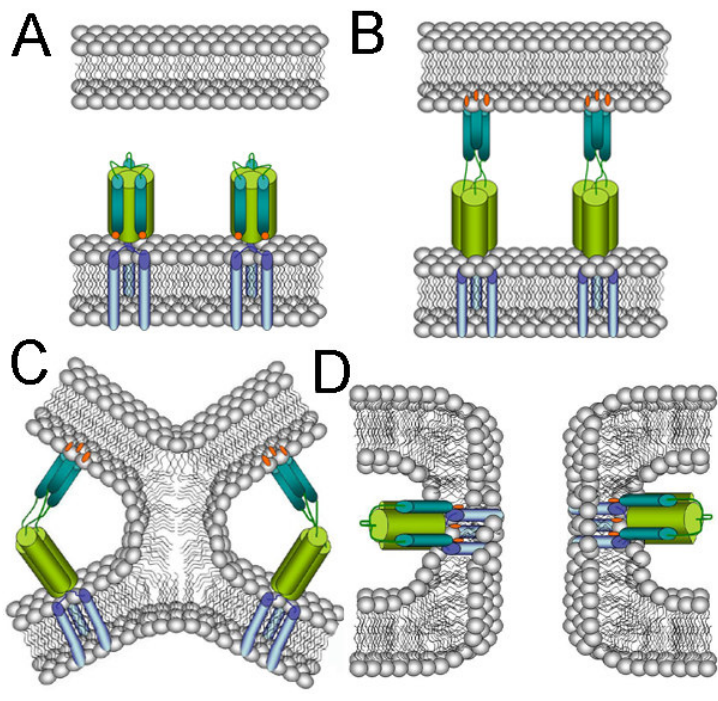
FIGURE 1. Conformational changes in influenza HA protein related to membrane fusion. (A) The trimeric membrane fusion protein spike assembly of influenza virus is anchored into the viral membrane in a preactivated state. Shown schematically, the transmembrane domain is dark blue, the N-terminal fusion peptide is orange, the green cylinders depict α -helical structures. On acidification, a hypothesized “extended intermediate” conformation is generated in which the hydrophobic fusion peptide is extended towards the targeted membrane. (B) After anchoring into the endosome’s membrane, to cross-link the two membranes, the fusion protein folds back into a hairpin, positioning the transmembrane domain and fusion peptide in close proximity. (C) This hairpin forces the two membranes close together and is essential for the process, leading to full merging of the bilayers. (D) A fusion pore forms when the C- and N-terminus are relocated adjacent to each other in the same